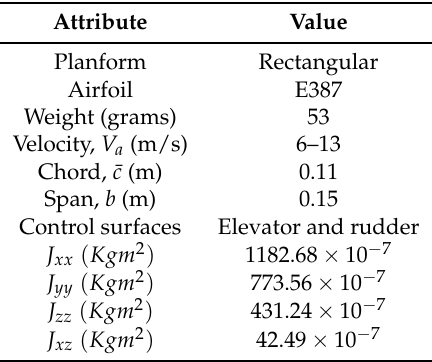
Table 1. 150 mm MAV—specifications.